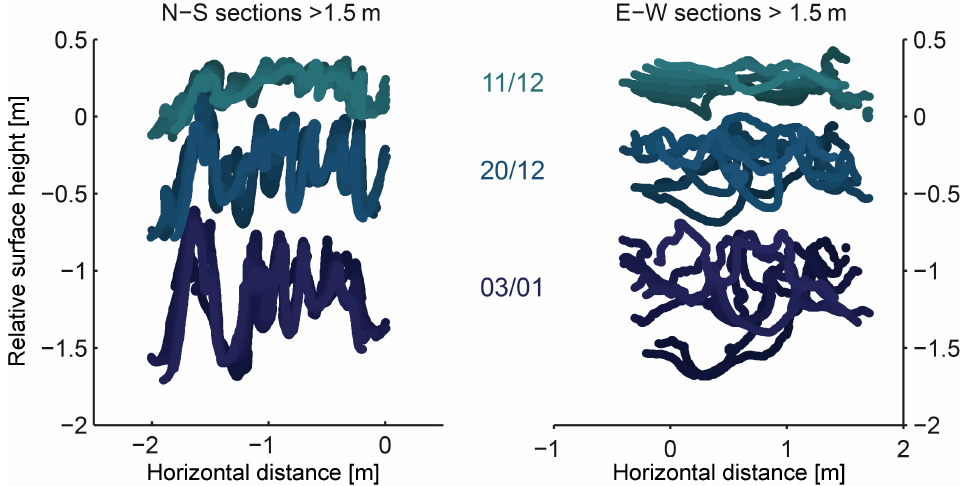
Figure 9. Examples of (a) N–S and (b) E–W-orientated cross sections longer than 1.5m, sampled at 0.1m intervals from which effective surface roughness properties were computed using the methods of Munro (1989, 1999). The local coordinates are relative to the NE corner marker of site A (Fig.